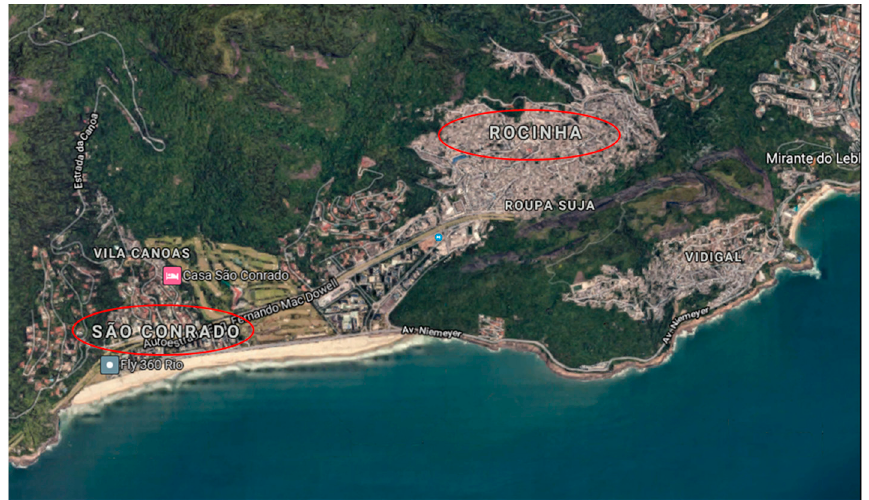
Figure 2. Aerial view of part of the South Zone of Rio de Janeiro. The red ellipses highlight São Conrado and Rocinha. Despite the proximity, Rocinha has twice the CFR of São Conrado (6.27% and 3.12%, respectively). However, its CFR is still lower than the average of the other favelas in Rio de Janeiro (9.08%). Image credits: Google Maps © .